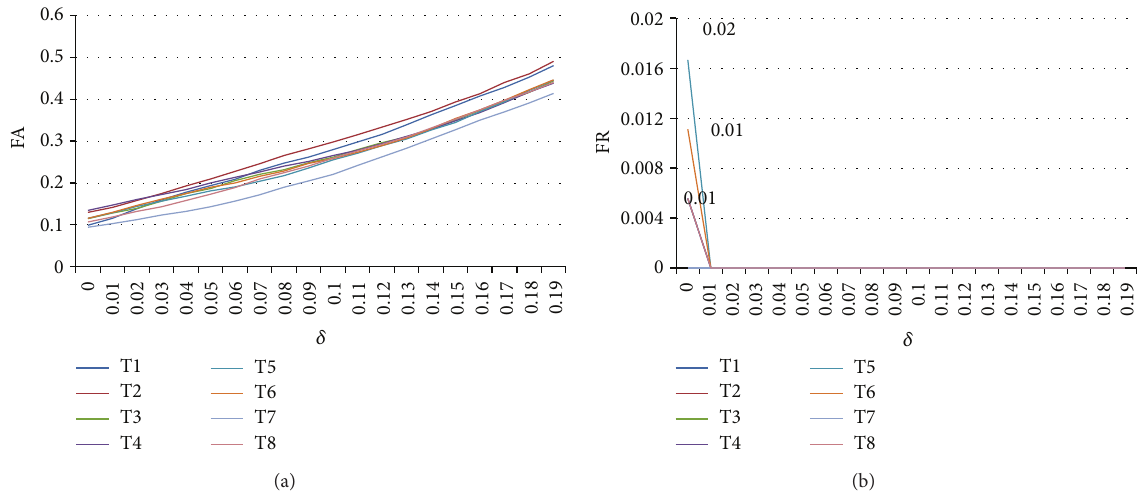
Figure 6: (a) FA rates of eight templates with different threshold and (b) FR rates of eight templates with different threshold.